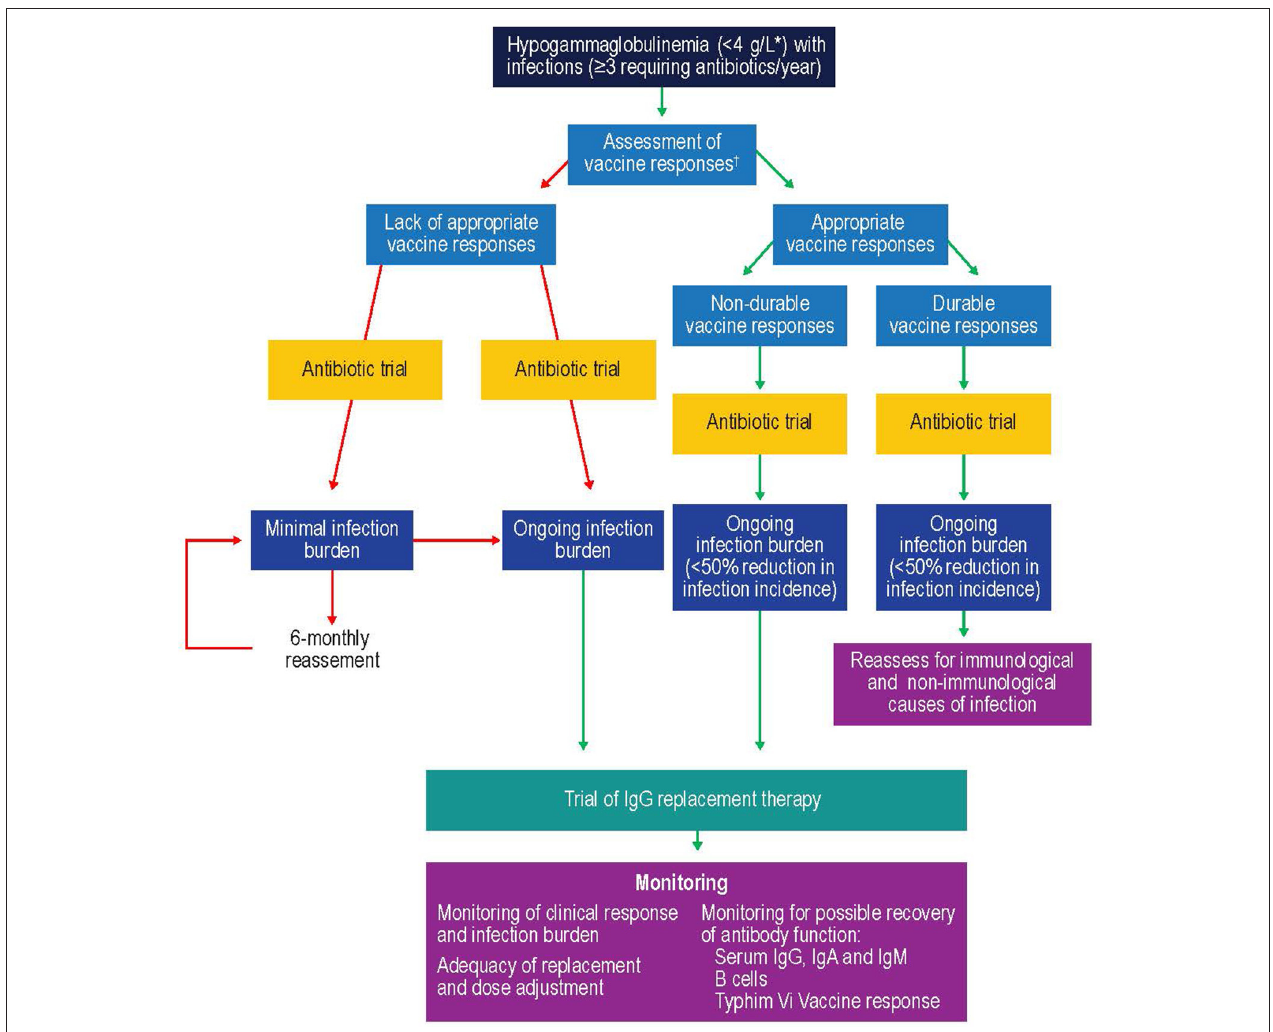
FIGURE 5 | Suggested protocol for the investigation, monitoring, and management of secondary antibody deficiency . Reproduced with the permission of the copyright holder John Wiley & Sons Inc ( 5). *See (57, 58, 214); † Only > 6 month after solid organ transplant. CSMB, class-switched memory B cells; IgA, immunoglobulin A; IgG, immunoglobulin G; IgM, immunoglobulin M; SOT, solid organ